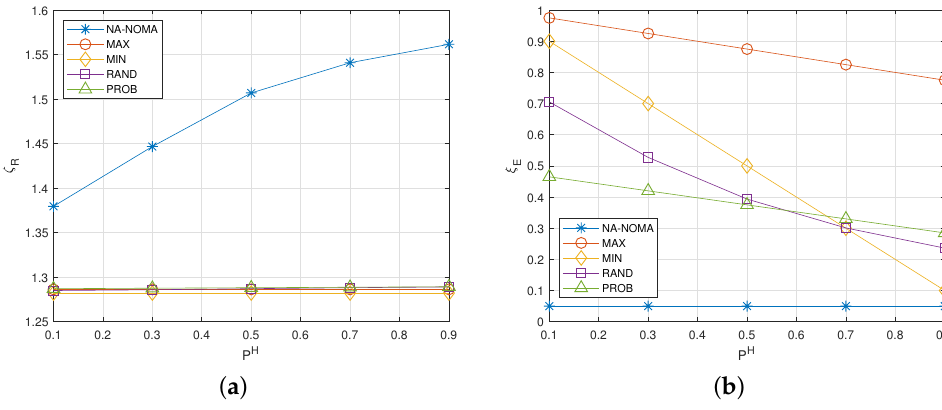
Figure 3. Effect of P H . ( a ) Average aggregated data rate. ( b ) Energy outage probability.